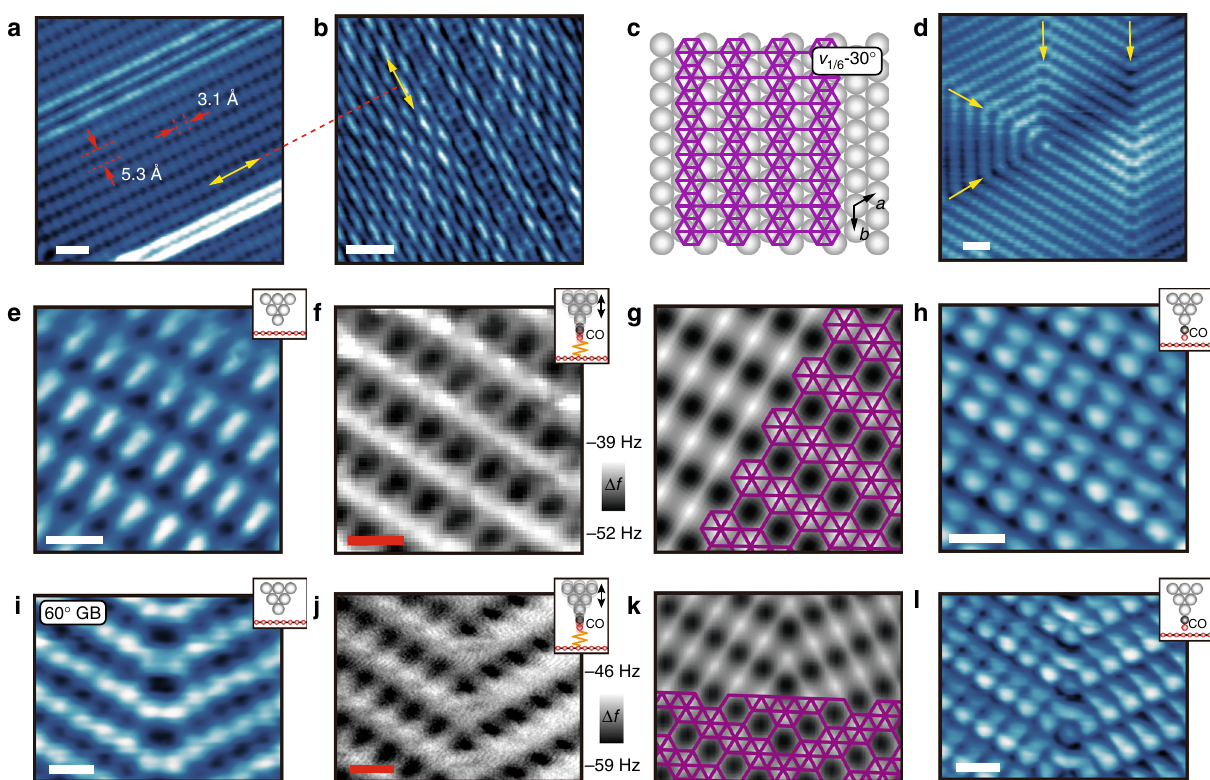
Fig. 2 Imaging v 1/6 − 30° phase borophene structures with bare and functionalized probes. Bare-tip STM images of a a v 1/6 − 30° phase borophene domain and b a neighboring v 1/5 phase borophene, where the HH rows in each phase are perpendicular (yellow arrows). c Schematic of v 1/6 − 30° phase borophene. d Bare-tip STM image of polycrystalline v 1/6 − 30° phase borophene with multiple 60° GBs (yellow arrows). e Bare-tip, f CO-AFM, g simulated CO-AFM, and h CO-STM images of v 1/6 − 30° phase borophene. The atomic structure is overlaid in g . i Bare-tip, j CO-AFM, k simulated CO-AFM, and l CO-STM images of a 60° GB within v 1/6 − 30° phase borophene. The atomic structure is overlaid in k . V s = − 3 mV in a , 4 mV in b , − 34 mV in d , 9 mV in e , 4 mV in h , − 34 mV in i , and 4 mV in l . Scale bars, 1 nm in a , 2 nm in b , 1 nm in d , 5 Å in e , f , h – j ,